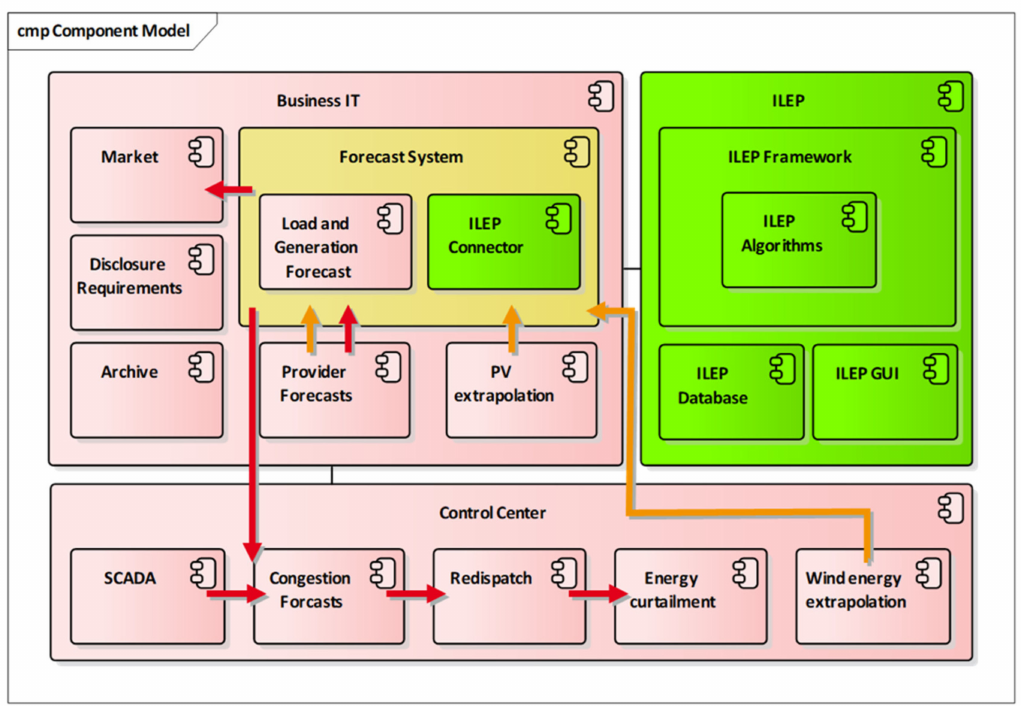
Figure 10. Existing (red), adapted (yellow), and new (green) forecast related system components, basic information flows during training (orange arrows) and operation (red